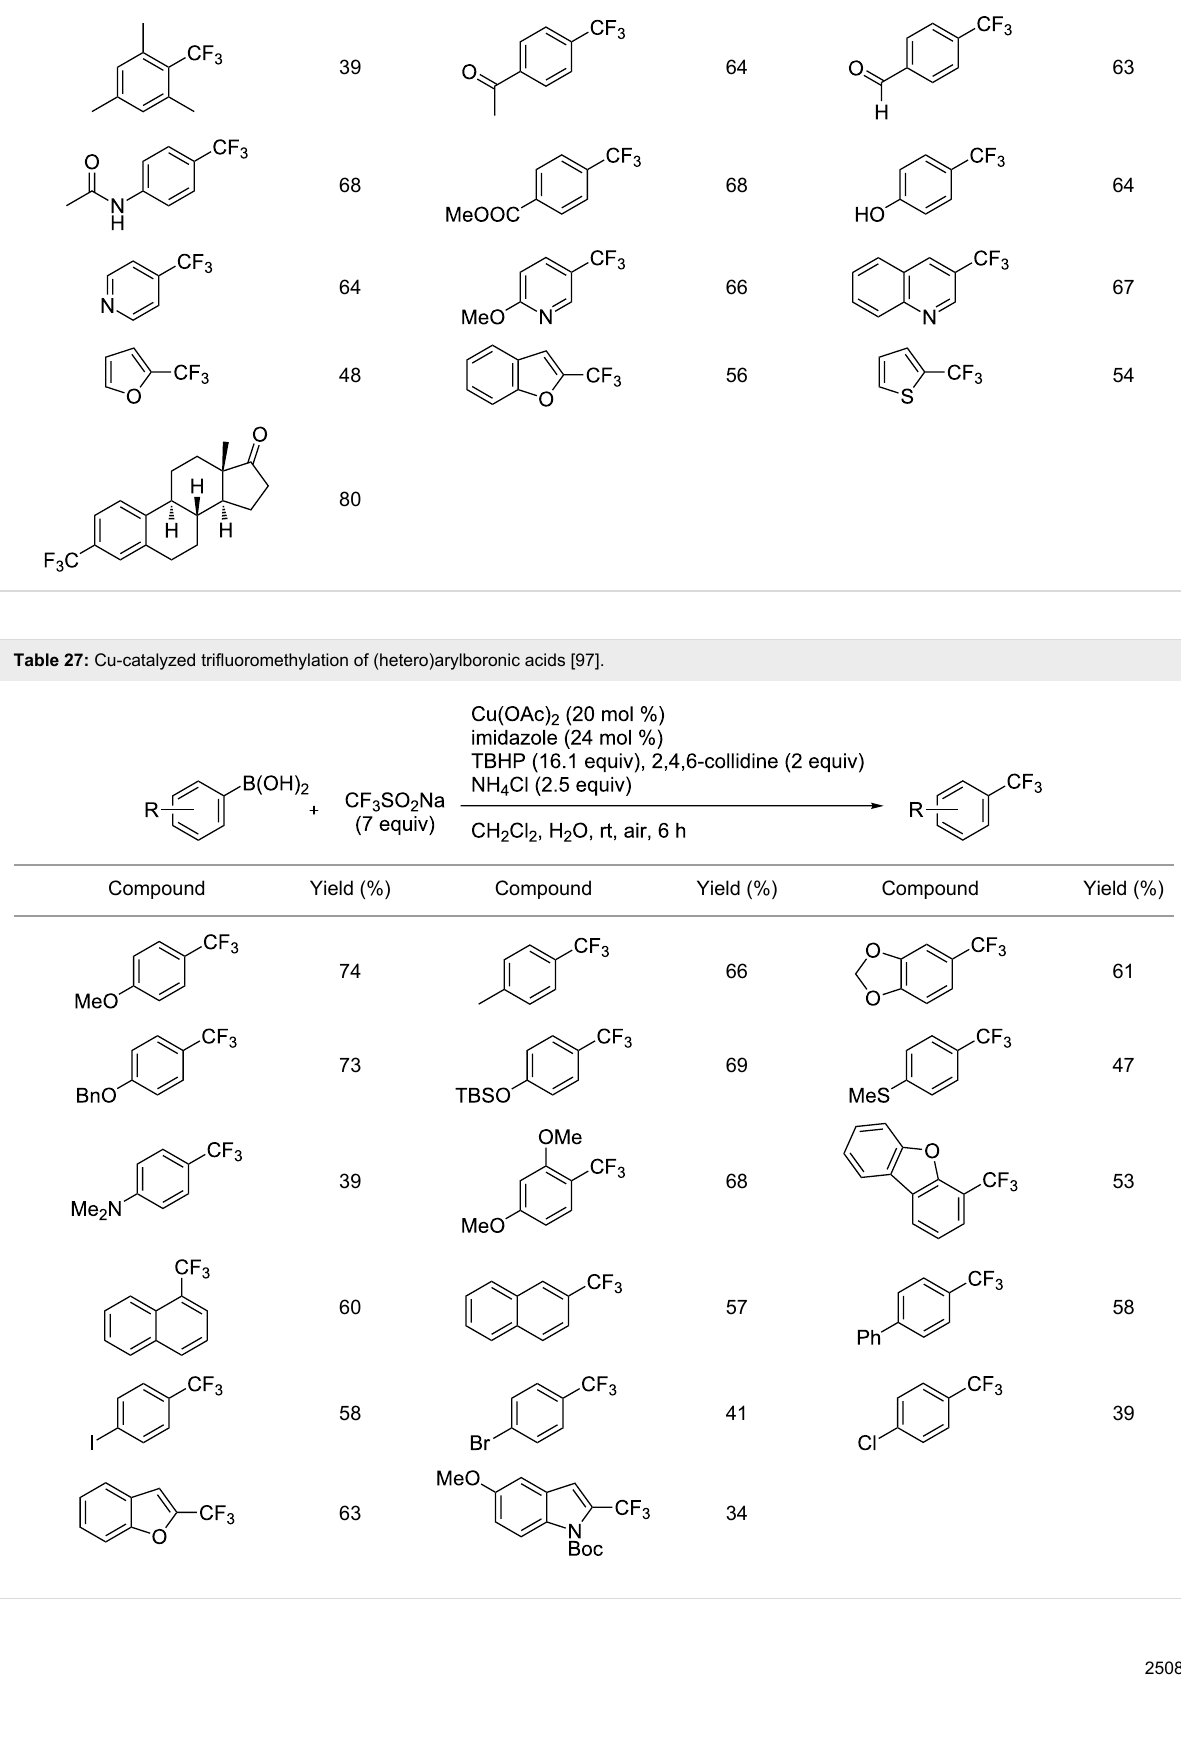
Table 26: Sanford’s Cu-catalyzed/Ru-photocatalyzed trifluoromethylation and perfluoroalkylation of (hetero)arylboronic acids [96]. (continued)